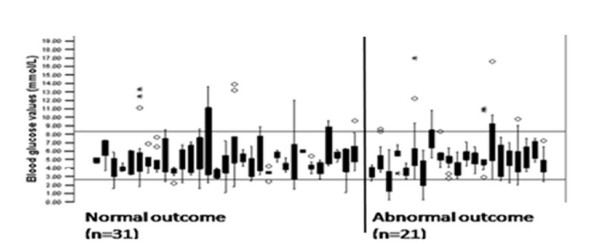
Distribution of blood glucose levels (mmol/L) in individual infants (n = 52) by neurodevelopmental outcome at 24 months. Horizontal lines represent normal range of blood glucose. The boxes and whiskers represent the ranges between 25th and 75th percentiles and between 10th and 90th percentiles respectively. The circles (outliers) represent cases with values that are between 1.5 and 3 box lengths from either end of the box. Asterisks (extremes) represent cases with values more than 3 box lengths from rather end of the box.